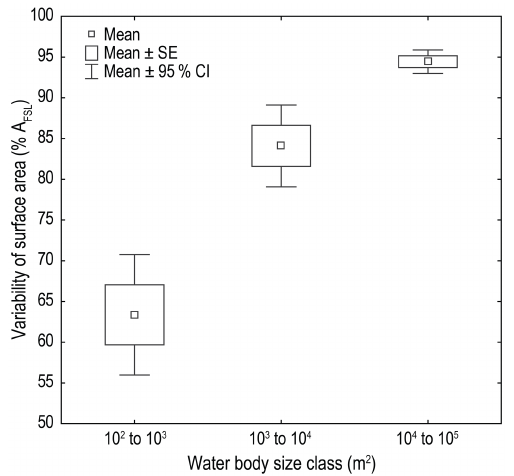
Figure 5. Monthly CH 4 emissions from a single monitoring site on an urban lake (St Lucia 1) across the annual cycle. Values indicate mean emission rates ± SE (standard error) and 95% CI (confidence intervals).